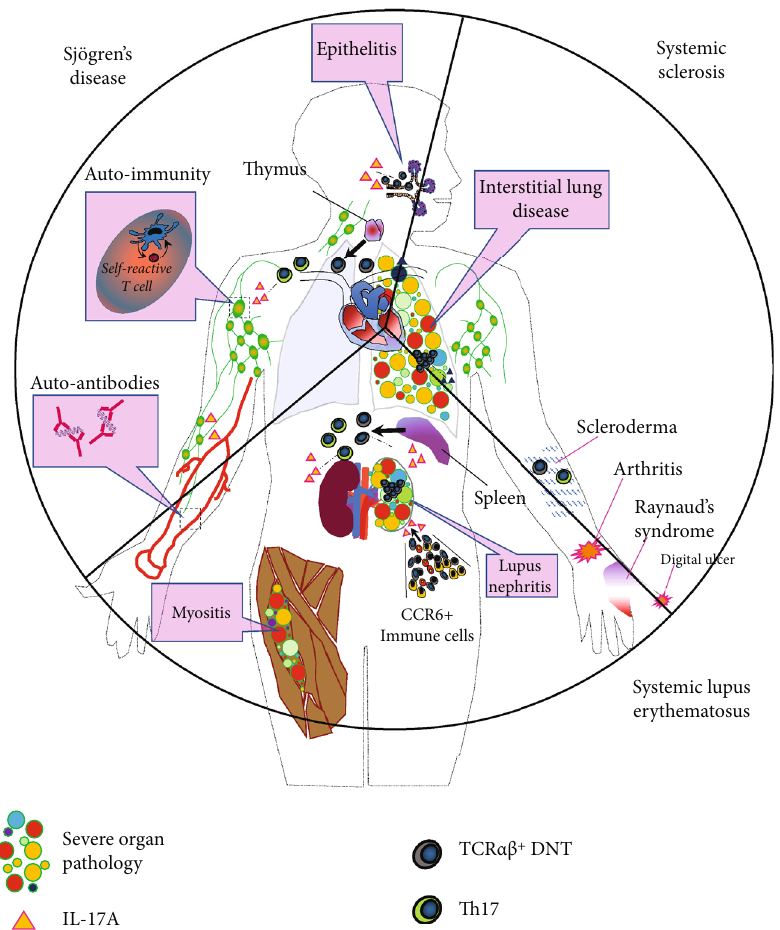
Figure 2: Schematic representation of the contributive role of IL-17A in the pathogenesis of three major systemic autoimmune diseases. Growing evidence suggests that the abundance of IL-17A and its prime source, i.e., Th17 cells and DNTs, in the target tissues may deteriorate clinical and immunological patterns in any of these autoimmune disorders by promoting (1) autoimmunity, immune cell recruitment, and vascular-immune interactions in SLE, (2) induction of autoantigen expression and undermining of endothelial integrity/barrier function in SS, and (3) fi brogenesis (indirect mechanism) in myo fi broblast precursors and vasculopathy in SSC. Th17 and DNTs, originating from the spleen and thymus, display excellent properties to in fi ltrate disease-associated organs, which in concert with tissue-derived factors ensure coordinated temporal-spatial distribution as well as activation of IL-17A-expressing T cells within lymphoid and nonlymphoid